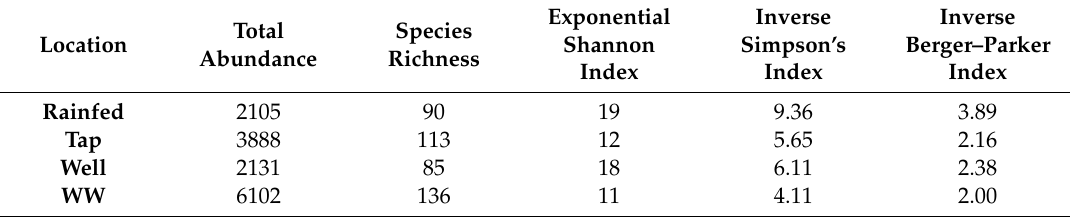
Table 3. Total abundance, total species richness, and diversity indices based on Hill numbers of arthropod communities found on vegetable fields in four UPA locations and with different irrigation water sources, namely, rainfed (RF), tap water (Tap), well water (Well), and wastewater (WW), in Tamale, Ghana in August 2016.